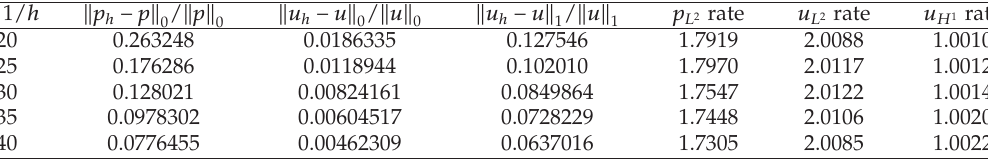
Table 4: Numerical results for LGIM in (cid:2) 4, 7, 19 (cid:3) with NCP 1 - P 1 element.